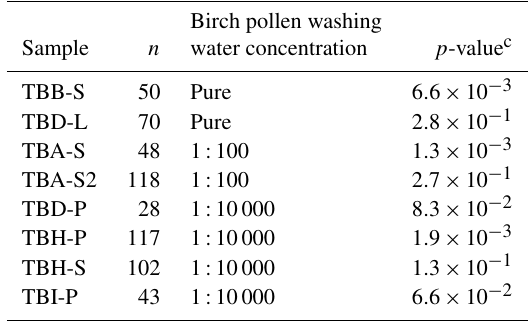
Table 2. The results for the Wilcoxon–Mann–Whitney test. All given samples were shown to match birch pollen washing water or a dilution thereof. Pure birch pollen washing water is marked with pure, the 1:100 dilution equivalent to 10 8 INPmg − 1 is marked with 1:100, and the 1:10000 dilution equivalent to 10 6 INPmg − 1 is marked with 1:10000. n represents the number of data points used for comparison for each sample a . The used significance level α b was 0.1 %. Birch pollen washing